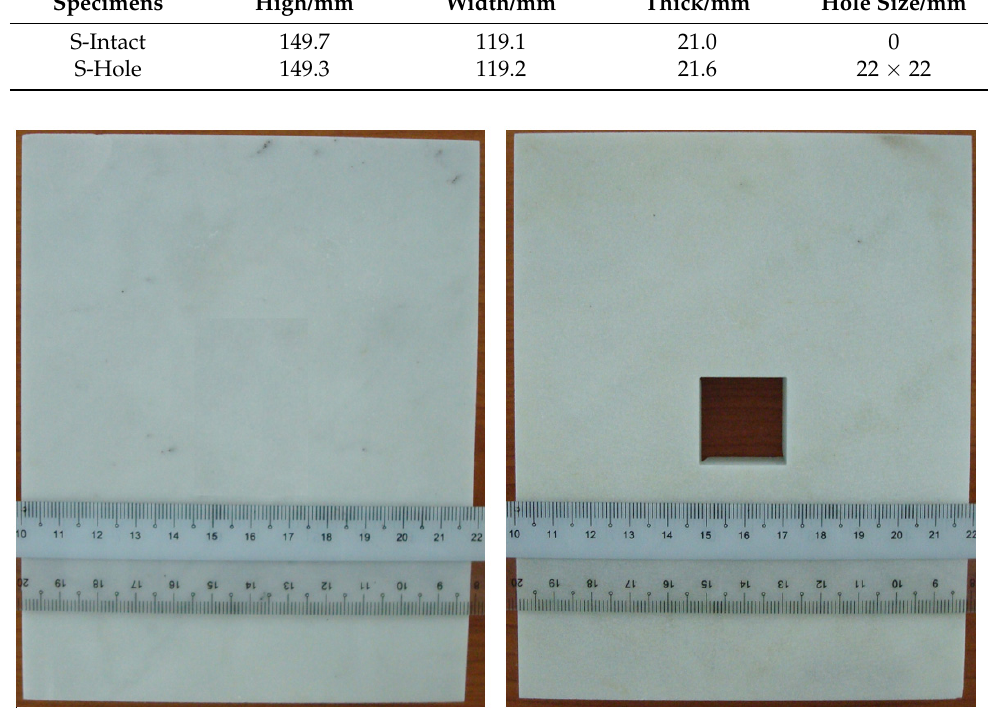
Figure 3. Intact specimen and specimen with rectangle hole.